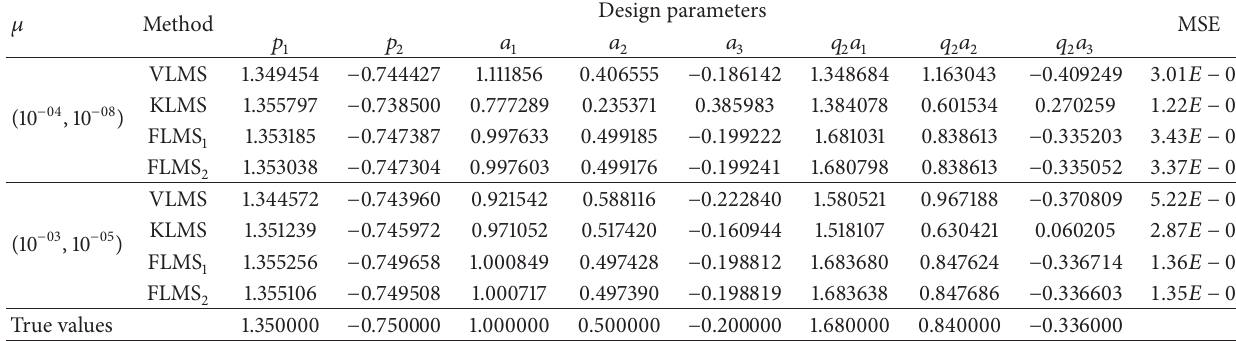
Table 6: Comparison of proposed results against true values of INCAR model for 20 dB